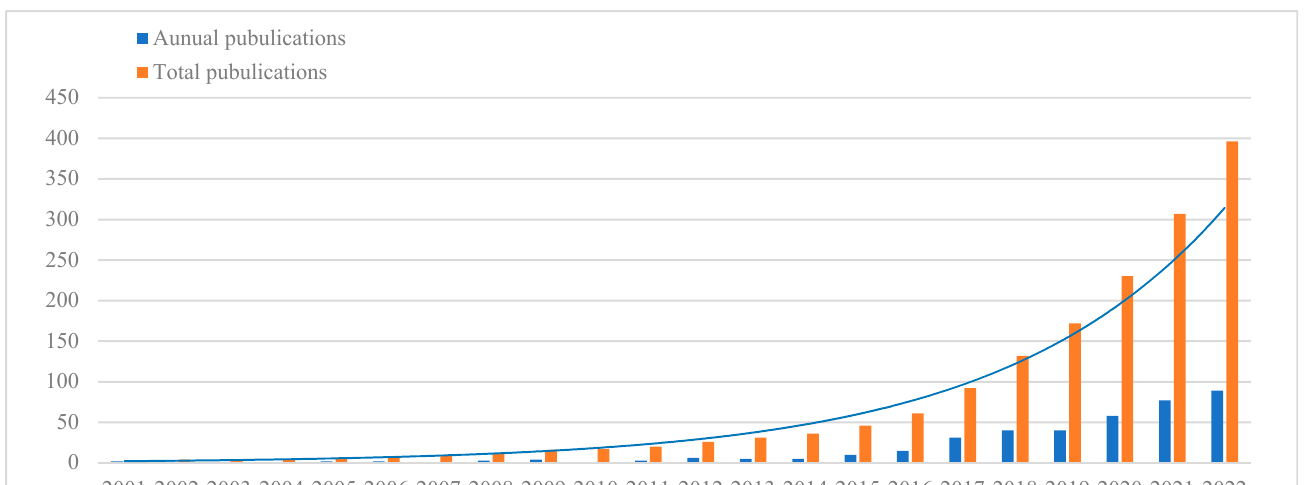
Figure 2. Publications on high-density city research from 2001 to 2022.